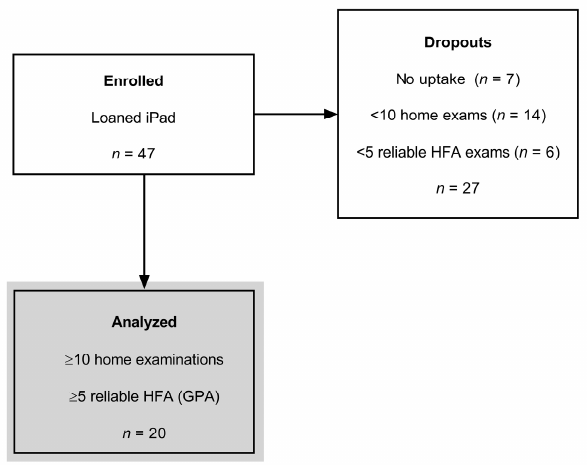
Figure 2. CONSORT diagram for the long-term visual field telemedicine trial. Numbers given are total number of participants. Forty of the forty-seven enrolled participants returned at least one home examination and were included in our analysis of Mean Absolute Error (see Figure 3). Twenty participants performed a minimum of 10 home examinations and provided 5 reliable HFA exams in-clinic (which enabled guided progression trend analysis, GPA). This group was included in the concordance and retention analysis (shaded area). Note, two of the patients in the analysed group showed progression, which will be detailed